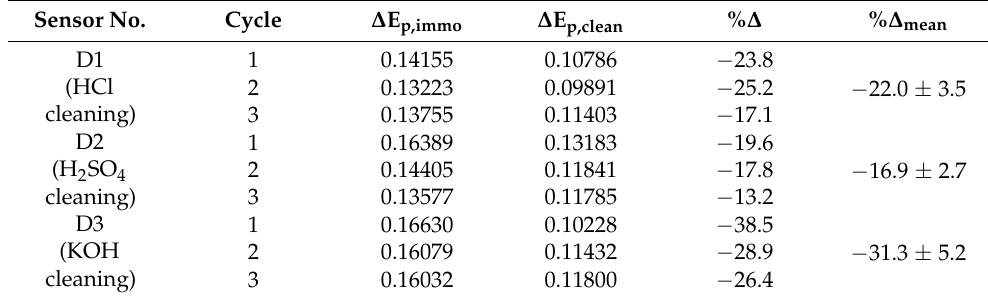
Table 3. Changes in potential as a percent difference (% ∆ ) from their original, uncleaned sample values. Sensor